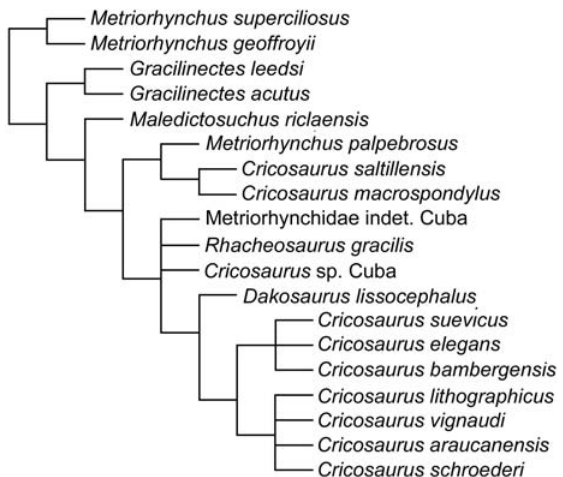
Fig. 8. Results of the phylogenetic analysis, simplified strict consensus topology of 2592 most parsimonious cladograms of Cricosaurus bamber- gensis sp. nov. within Metriorhynchinae (step number = 1.508; CI = 0.417; RI = 0.843; RC = 0.352; HI =